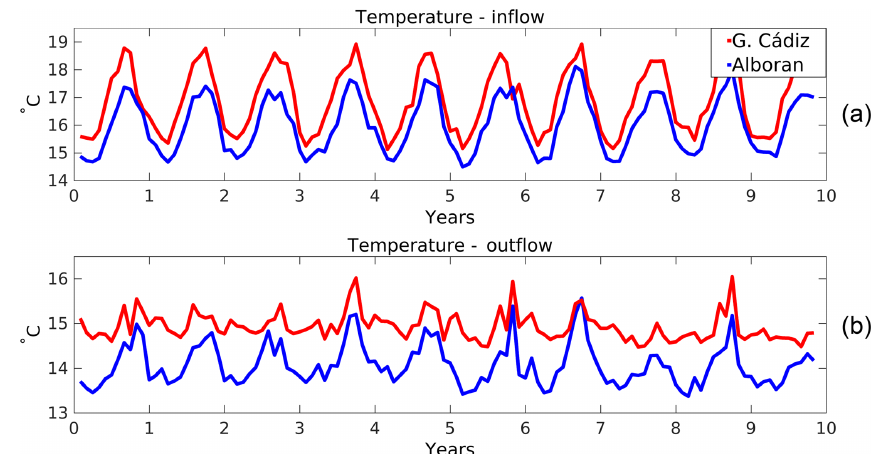
Figure 6. Monthly time series of temperature at the boundaries of the strait for (a) the inflow and (b) the outflow.